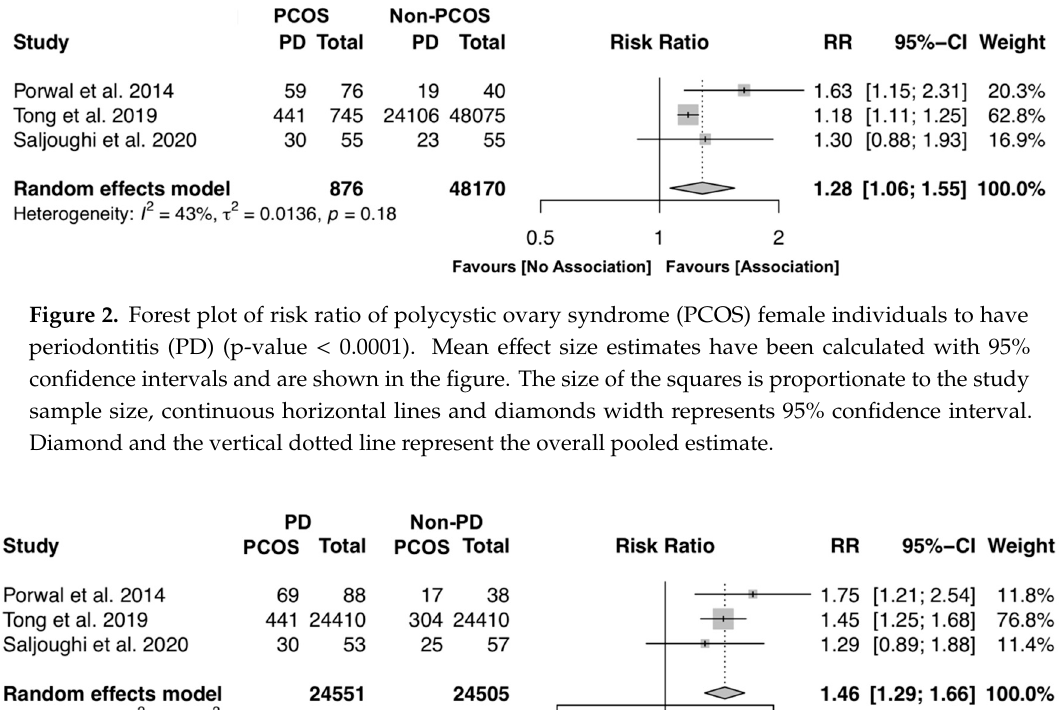
Figure 3. Forest plot of risk ratio of PD female individuals to have PCOS (p-value < 0.0001). Mean effect size estimates have been calculated with 95% confidence intervals and are shown in the figure. The size of the squares is proportionate to the study sample size, continuous horizontal lines and diamonds width represents 95% confidence interval. Diamond and the vertical dotted line represent the overall pooled estimate.